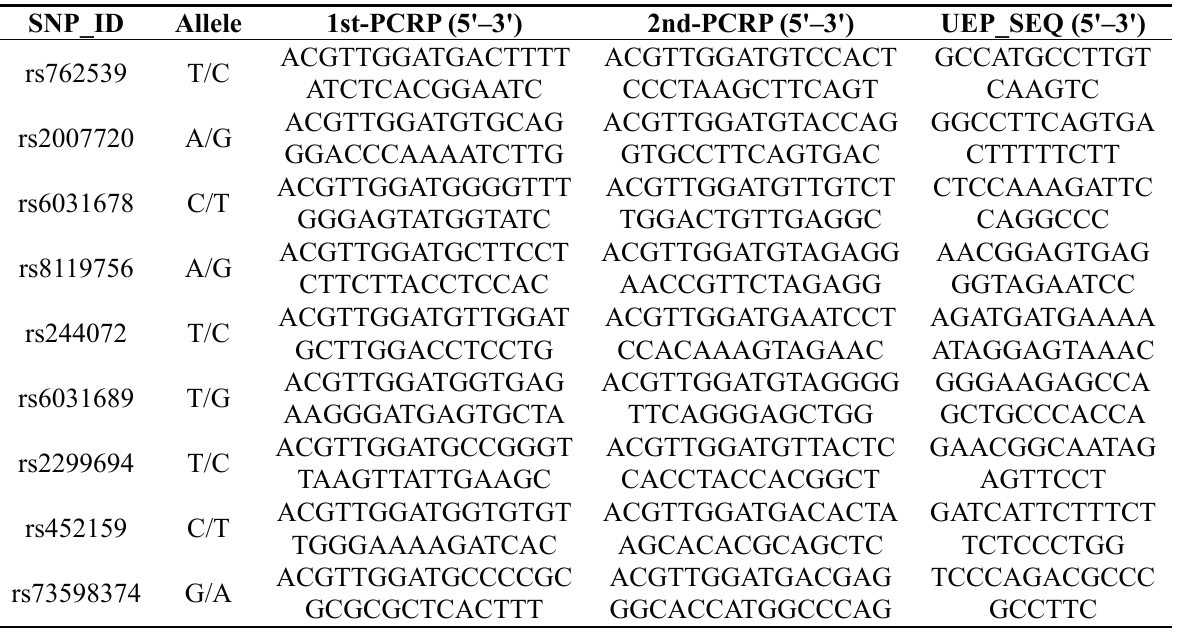
Table 6. Primers used for this